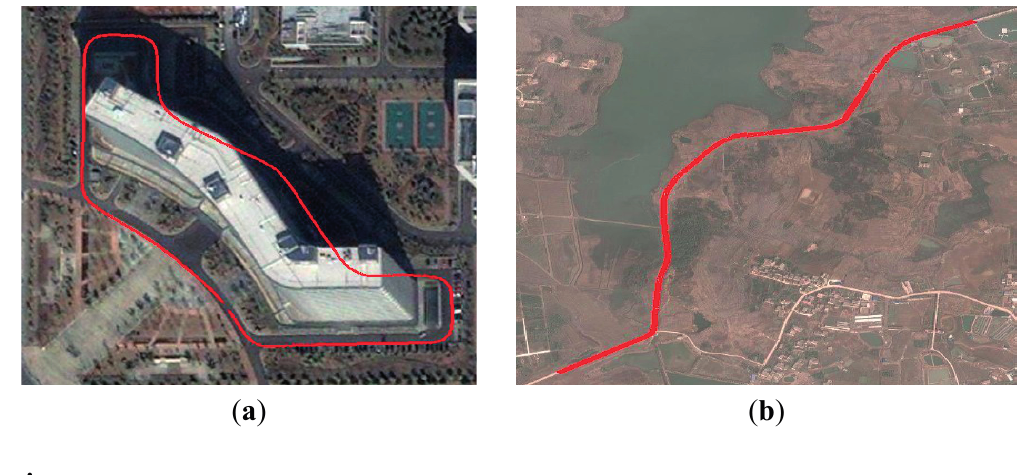
Figure 18. The GPS trajectory of “Intelligent Pioneer” recorded during experiment. ( a ) The red line indicates the trajectory recorded in the zone; ( b ) The red line indicates the trajectory recorded in the rural